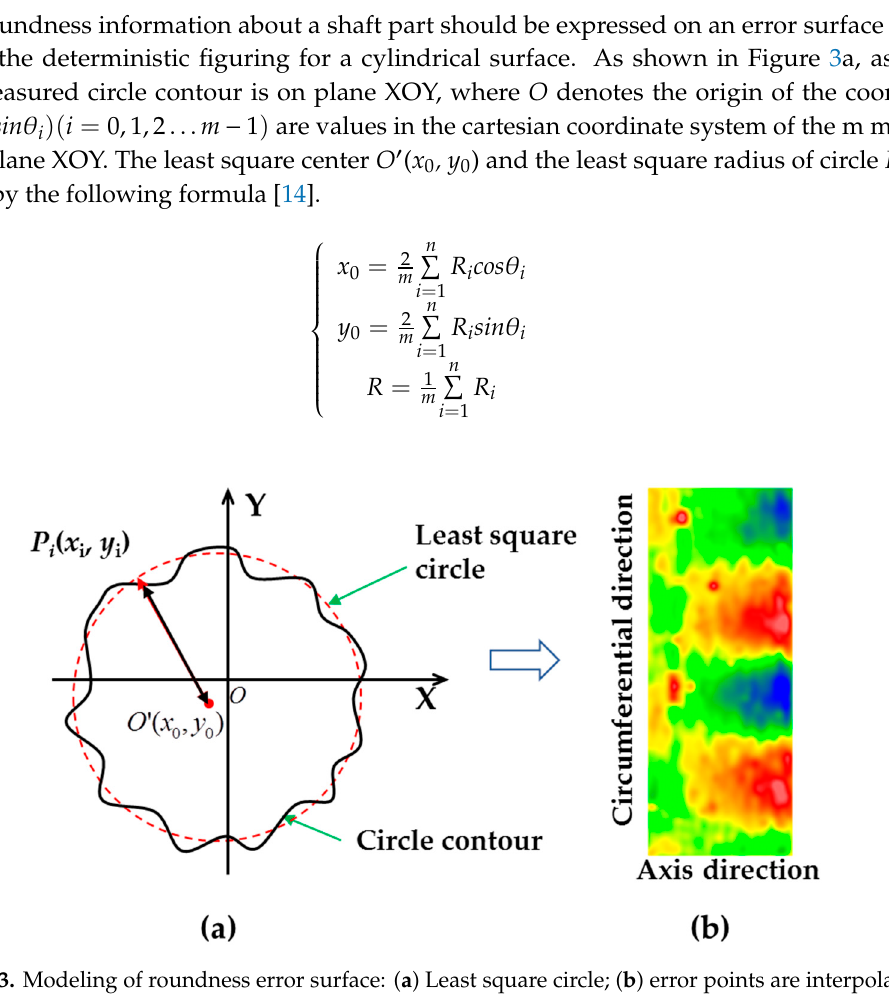
Figure 3. Modeling of roundness error surface: ( a ) Least square circle; ( b ) error points are interpolated to a roundness error surface.